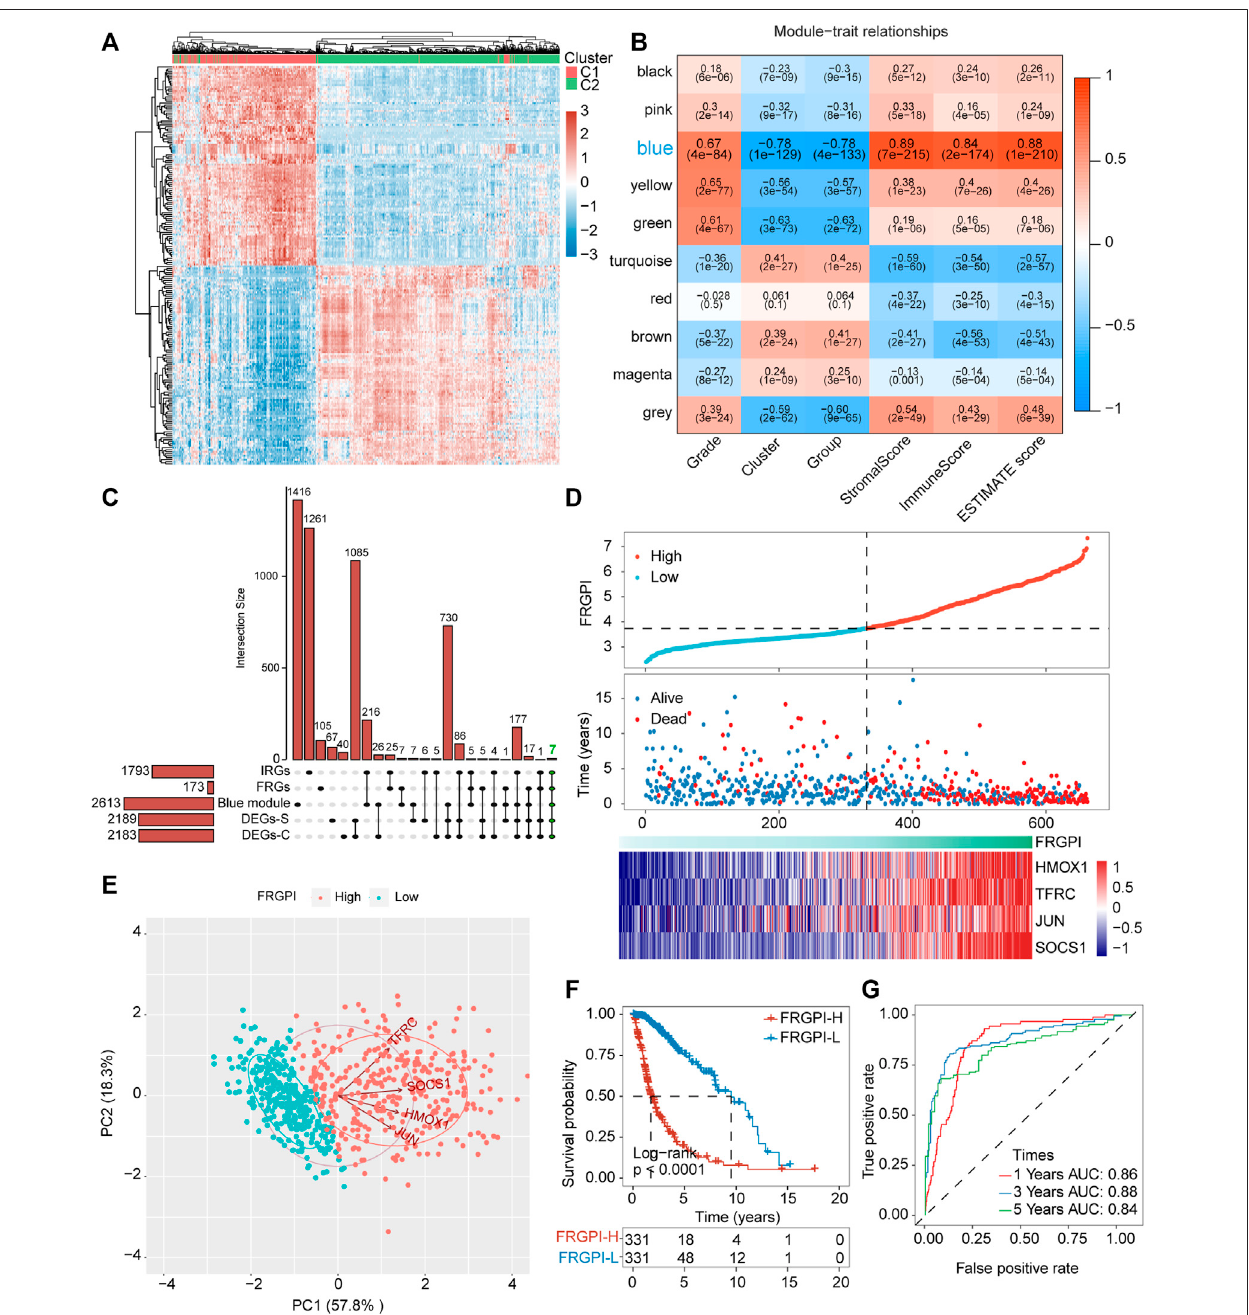
FIGURE 5 | FRGPI was developed based on FRGs for glioma. (A) Differential gene expression heat map, where different colors represent expression trends in different tissues. Due to the large number of differential genes, the 50 up-regulated genes and 50 down-regulated genes with the largest differential changes are shown here. (B) Correlation of weighted gene correlation network analysis (WGCNA) modules with ferroptosis-related subtypes and immuneScore. (C) Upset plot for DEGs between the two ferroptosis-related subtypes, DEGs between the two ferroptosis-related subgroups, FRGs, IRGs and genes in blue module. IRGs, immune- relatedgenes. (D) FRGPI,survivaloutcomeand HMOX1 , TFRC , JUN and SOCS1 expressionpro fi lesofeachsampleareshown. (E) Principalcomponentanalysis(PCA) plot of glioma samples based on HMOX1 , TFRC , JUN and SOCS1 expression pro fi les. (F) Kaplan – Meier analysis of glioma patients with low or high FRGPI. (G) ROC curves predicted prognostic value of FRGPI in glioma patients.